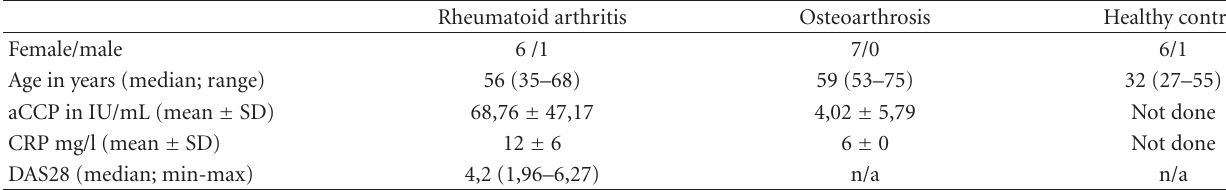
Table 1: Clinical characteristic of